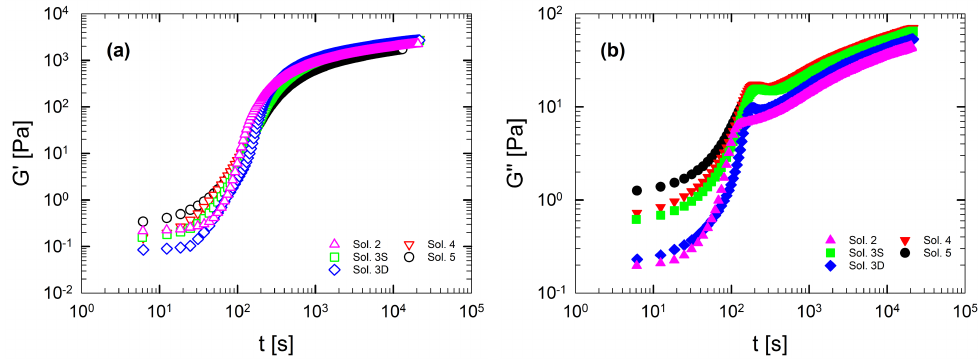
Figure 9. ( a ) Elastic and ( b ) viscous moduli as a function of time for the entire set of multi component gelatin solutions. The relative temperatures are Sol.2: 21 °C; Sol.3S: 24 °C; Sol.3D: 21 °C; Sol.4: 24 °C; Sol.5: 26 °C.